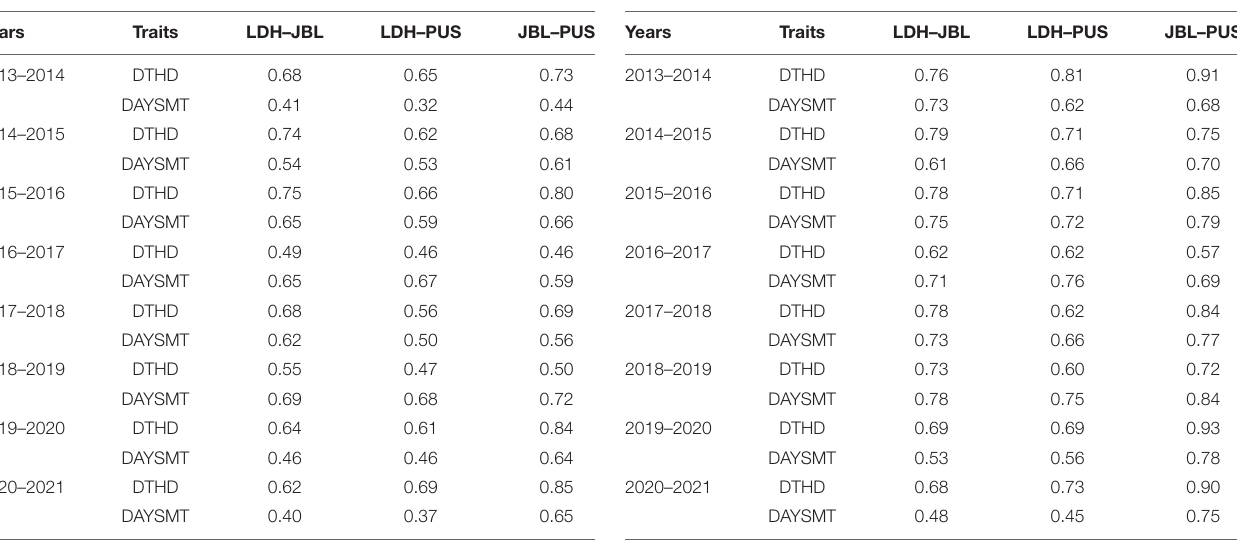
panels (panels 2015, 2017, 2018, 2019, and 2021), with additive effects ranging between 0.95 and 2.1 days and explained 4.9– 21.1% of the phenotypic variation. We also observed that 70 markers were significantly associated with DH in Ludhiana in one dataset only, which included 27 markers on chromosome 2B, 14 markers on chromosome 7B, 11 markers on chromosome 4D, 10 markers on chromosome 7D, four markers on chromosome 5B, and markers 3A_21112167, 3D_56844252, 4A_684814200, and 7A_174693955.